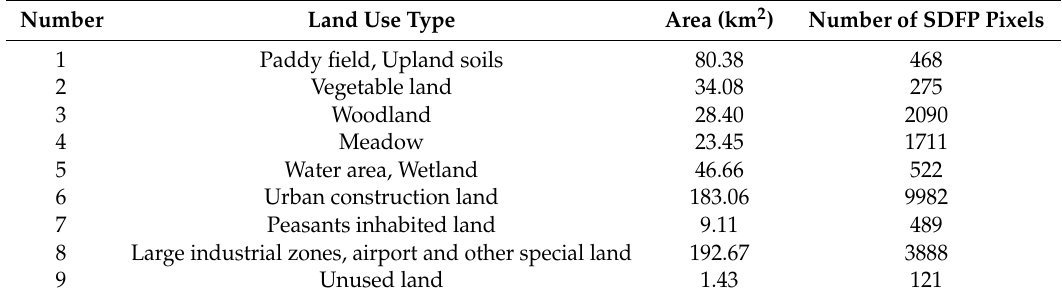
Table 2. Land use classification and statistics for the different land use types.